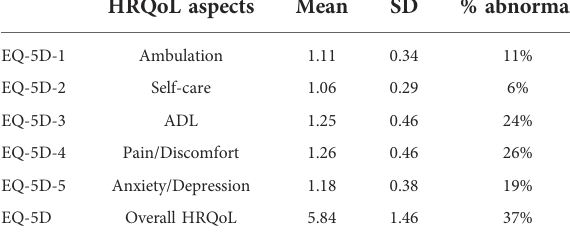
TABLE 5 Summary of the HRQoL scores for the patients. TABLE 3 Summary of the clinical data for the